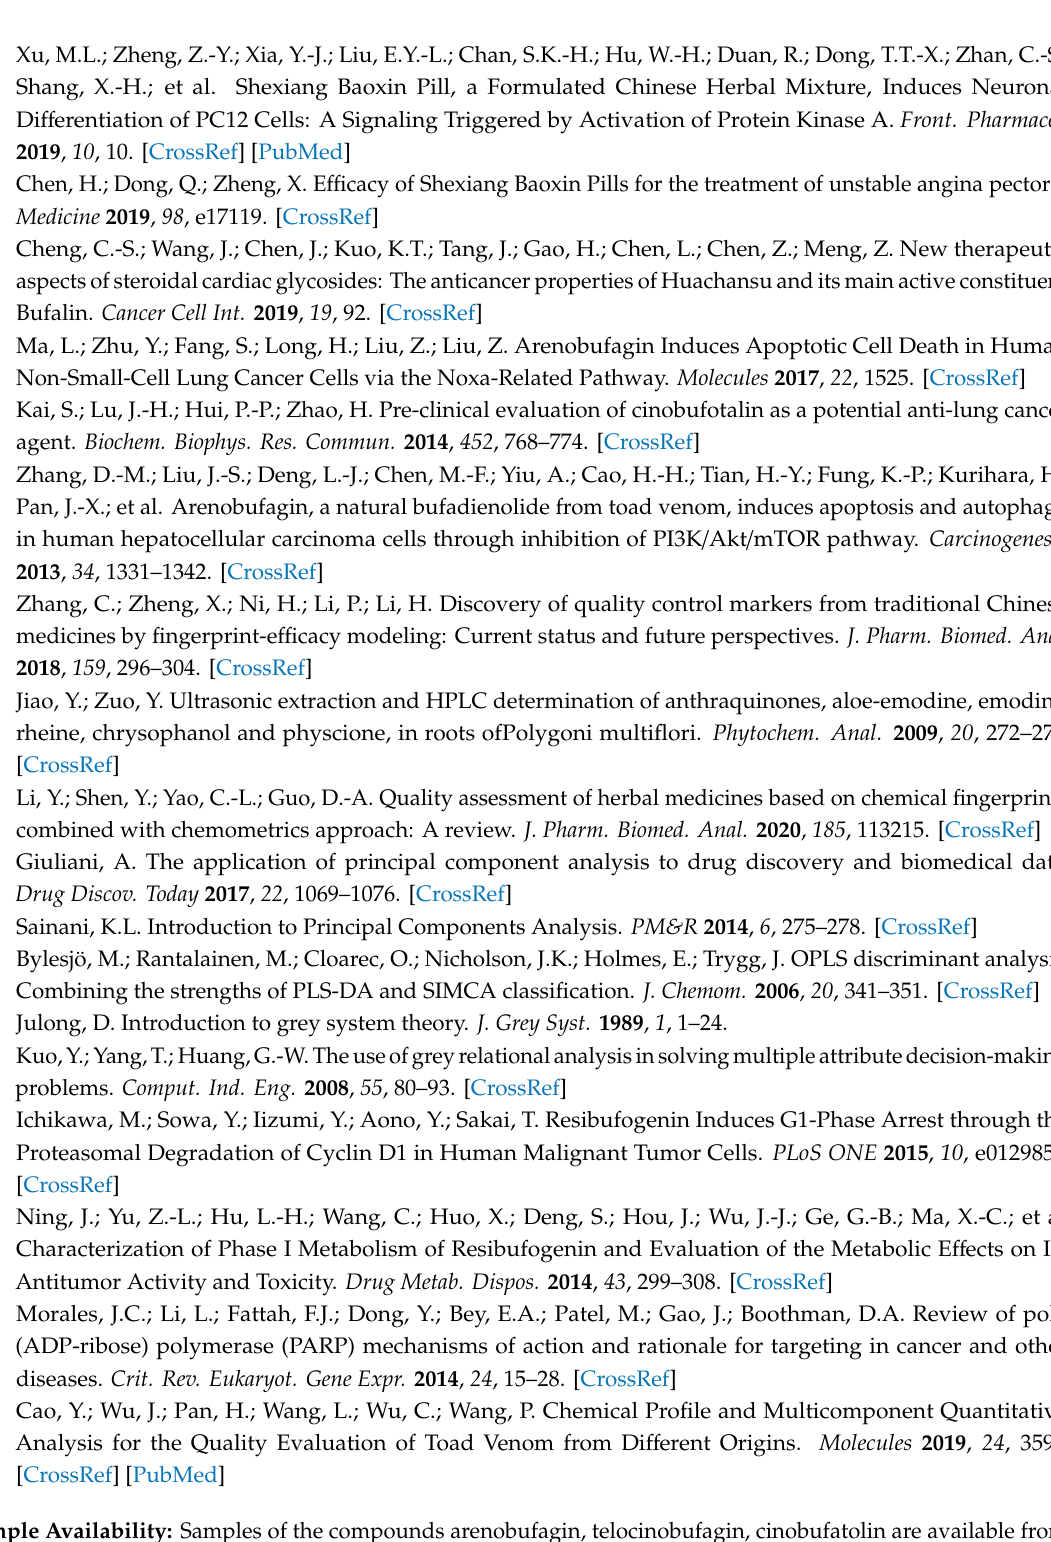
Sample Availability: Samples of the compounds arenobufagin, telocinobufagin, cinobufatolin are available from the